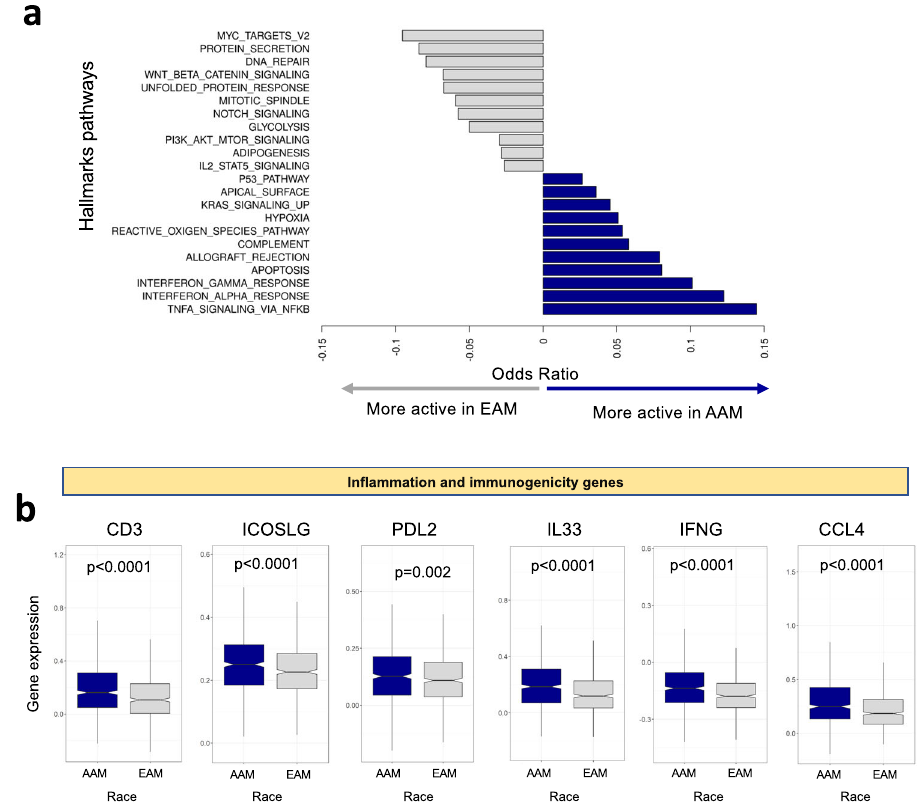
Fig. 3 Activation of different signaling pathways drives prostate cancer in AAM and EAM. a The bar plot depicts the log odds of pathways that have a signi fi cant association with AAM and EAM after adjusting for clinical variables and false discovery. Many of the pathways more active in the AAM are related to the immune response. Pathways more active in the EAM include those related to DNA repair, glycolytic metabolism, and the cell cycle. b African Americans showed higher in fl ammation activity and higher expression of CD3 , IFNG , IL33 , and immune checkpoint inhibitors ( PDL2 , ICOSLG ). Abbreviations as in Fig. 1. Error bars represent the 95% con fi dence